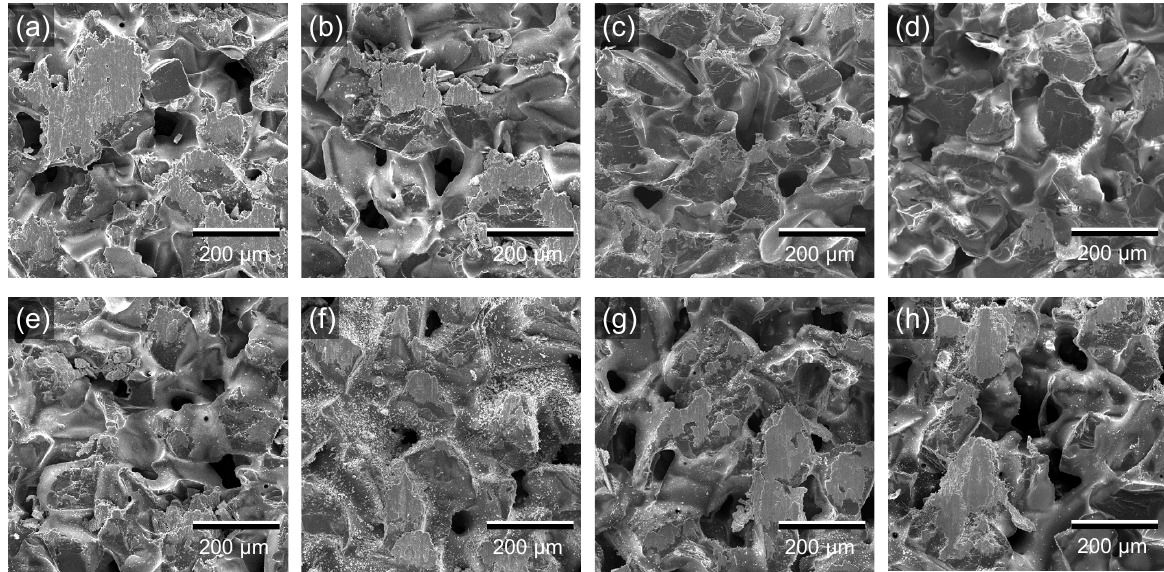
Figure 7. Wheel surfaces after grinding: ( a ) Ti; ( b ) 6Nb4Cu; ( c ) 18Nb2Cu; ( d ) 24Nb1Cu at 750